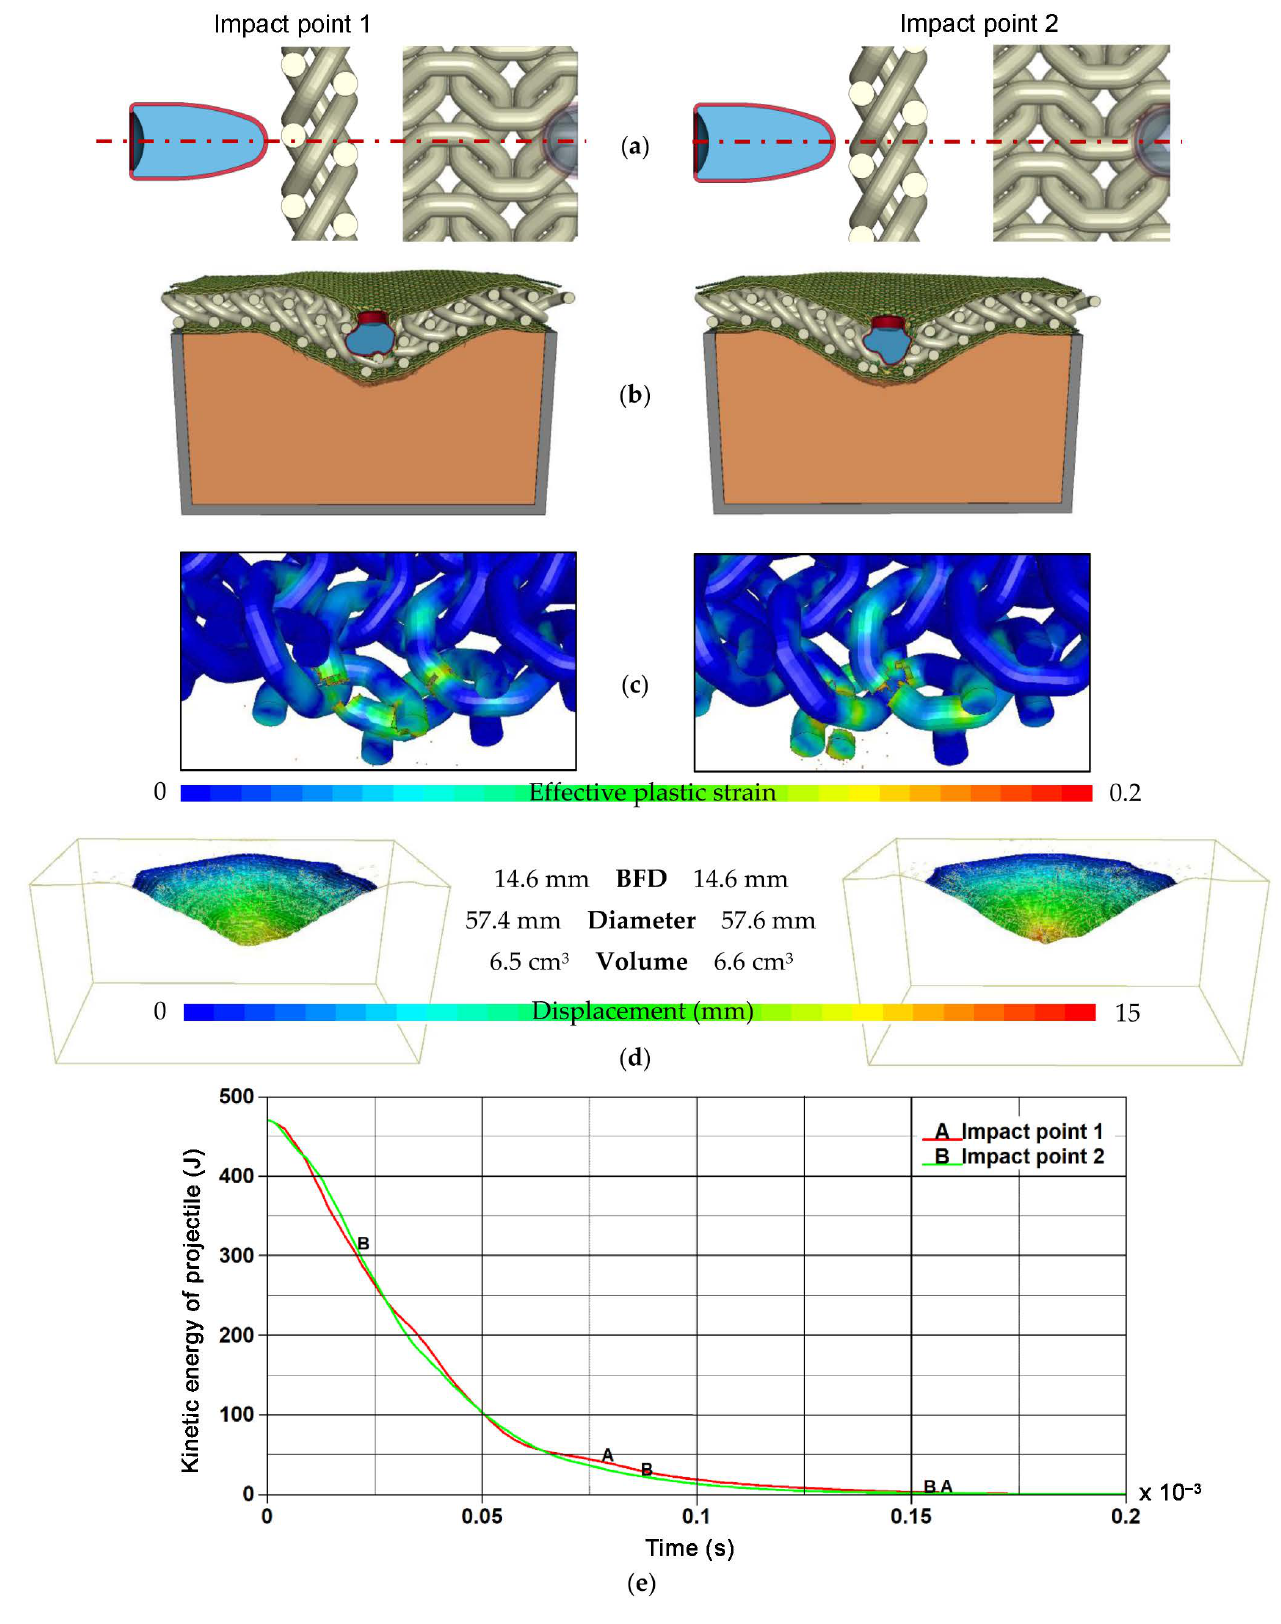
Figure 15. Results of simulation for S3 structure: ( a ) location of the impact point; ( b ) final deformation; ( c ) distribution of effective plastic strain in the titanium structure; ( d ) shape of the hollow in the ballistic clay and ( e ) plot of the projectile energy against time.